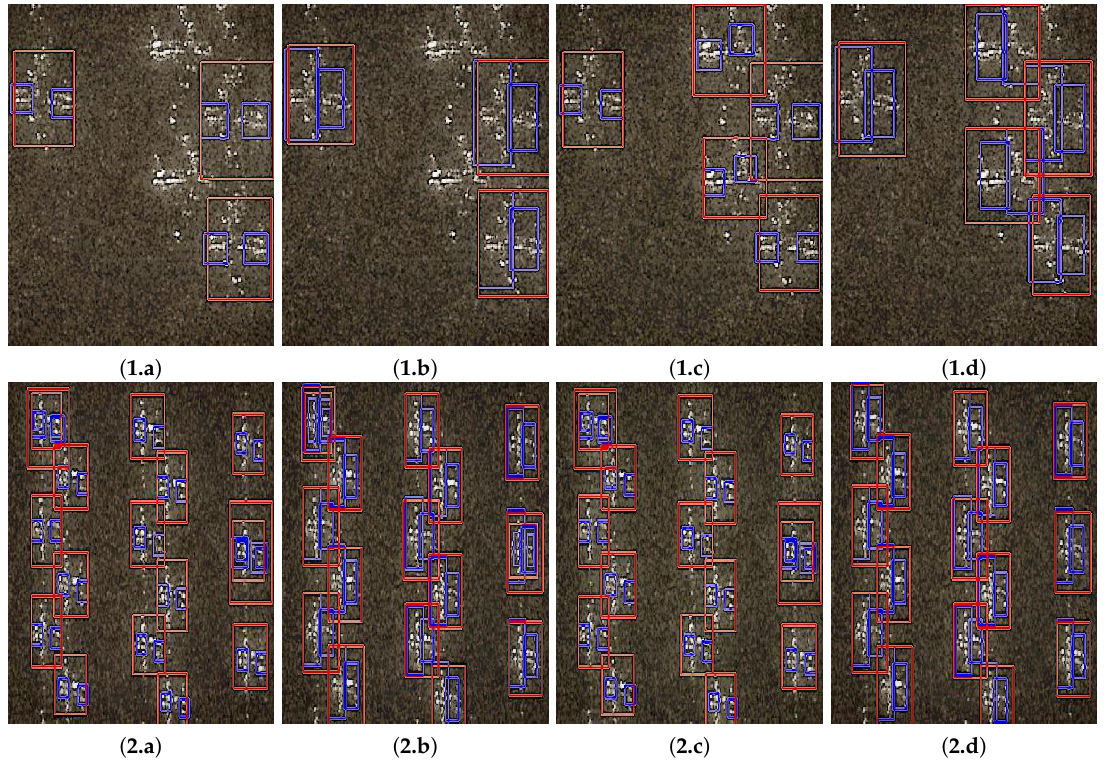
Figure 8. Detection results of the discriminative model and the ACSDM algorithm. ( 1.a ) discriminative model; ( 1.b ) discriminative model with adaptive component selection; ( 1.c ) discriminative model with penalty factor introduced; ( 1.d ) the ACSDM method; ( 2.a ) discriminative model; ( 2.b ) discriminative model with adaptive component selection; ( 2.c ) discriminative model with penalty factor introduced; ( 2.d ) the ACSDM